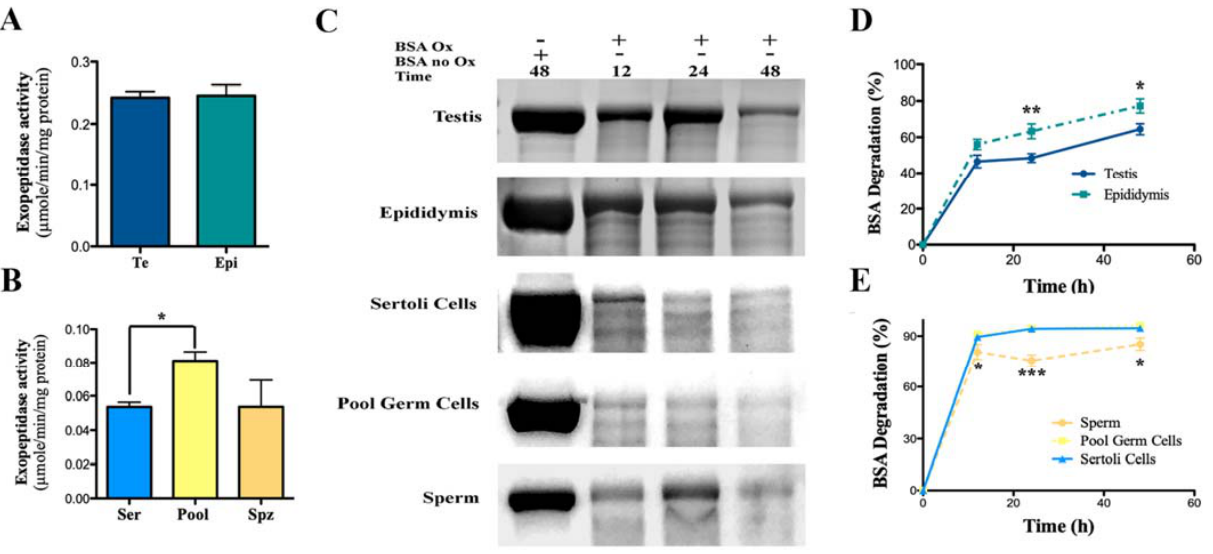
Figure 6. APEH activity in reproductive tissues and isolated cells. ( A , B ) Protein extracts from testis (Te), epididymis (Epi), Sertoli cells (Ser), pooled germ cells (Pool) and Spermatozoa (Spz) were obtained from male rats. Exopeptidase activity was measured at 37°C using N-acetyl-l-alanine p- nitroanilide (AANA) as substrate and expressed as specific activity. The results shown are repre- sentative of three independent experiments. ( C ) Endoproteinase activity was measured in tissues (Testis and Epididymis) and isolated cells (Sertoli, pooled germ, and spermatozoa) obtained from male rats. SDS-PAGE analysis of oxidized BSA treated at 37 °C with APEH purified from tissues and cells. ( D , E ) Electrophoretic data expressed as BSA degradation percentage at the indicated incubation times versus time 0, obtained by densitometric analysis with Image J software. The results shown are representative of three independent experiments. Significant differences were found with non-parametric one-way ANOVA (* p < 0.05 ; ** p < 0.01; *** p < 0.001). A significant increase in endoproteinase activity was found in extracts of epididymis compared to testis after 24 h of incubation with oxidized BSA ( p < 0.05; Figure 6C,D). In isolated cells (germ cells, spermatozoa, and Sertoli cells), endoproteinase activity was sig- nificantly increased in Sertoli and germ cells compared to spermatozoa ( p < 0.001, Figure 6C,E). As above, the specificity of the catalytic reaction was corroborated using 1 µM DDVP as an APEH inhibitor, which, as expected, significantly decreased endoproteinase activity ( p < 0.001) (Supplementary Figure S3B,C). 4. Discussion In this study, we report for the first time the presence of functional APEH in rat re- productive tissues (testis and epididymis) and isolated cells from the male reproductive tract (Sertoli cells, germ cells, and sperm). We observed that in somatic cells (Sertoli cells) and early germ cells such as spermatocytes, APEH is localized both in the nucleus and in the cytoplasm. This intracellular localization pattern was similar to that observed previ- ously for POP (EC 3.4.21.26), another member of the POP family [27]. According to that study, the POP signal is found in both the nucleus and the cytoplasm of proliferative cells such as gonocytes and spermatogonia, and also in Leydig and Sertoli cells. The nuclear localization of POP has also been described in other proliferative tissues [47], suggesting a role for this enzyme in DNA synthesis. In particular, this was observed in the mouse brain during neurogenesis [48]. Taken together, these antecedents could indicate a possi- ble role of APEH in some nuclear processes as suggested by a recent publication reporting APEH involvement in DNA repair through interaction with the scaffold protein XRCC1[49].